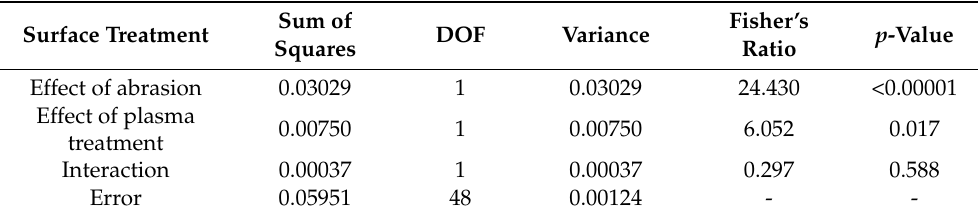
Table 5. Results of ANOVA applied to a 2-by-2 experiment (A1/B1 = AB_D5_v100, A1/B2 = AB, A2/B1 = D5_v100, A2/B2 = UN).